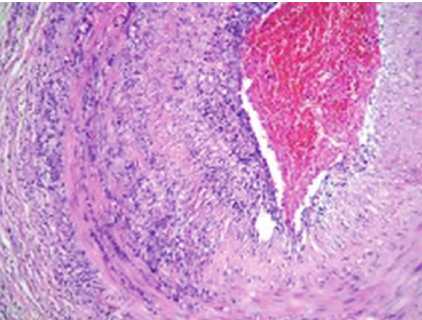
Figure 2: Multinuclear giant cells accompanying mononuclear inflammatory cell infiltration of artery wall in adventitia (arrow) (HE , ×10